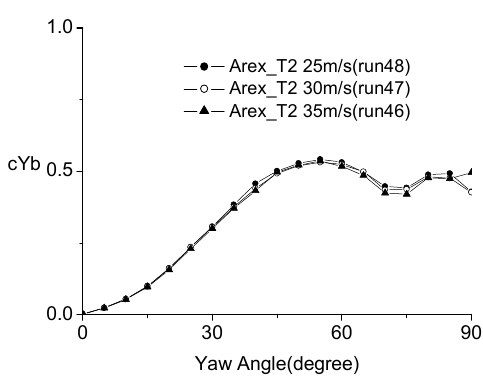
Figure 10 Side force coefficient (AREX T2-car)